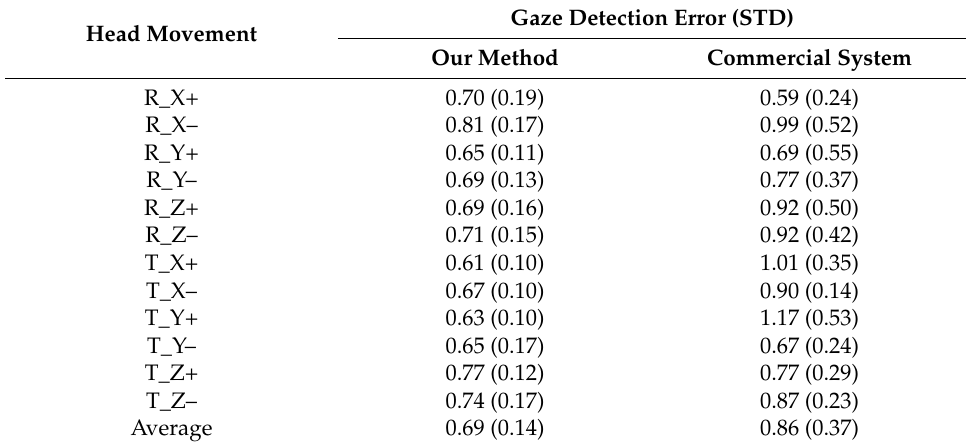
Table 7. Comparisons of gaze detection accuracies with commercial system (Tobii EyeX) (unit: %). Head Movement